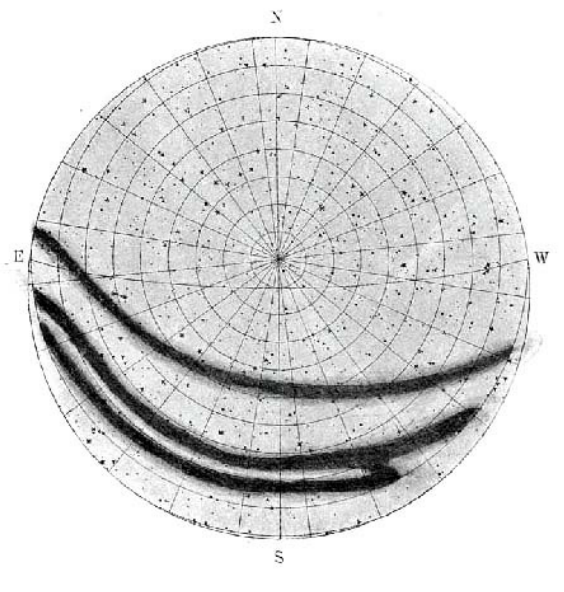
Fig. 7. All-sky drawing by Westman of the aurora as seen from Treurenberg Bay on 27 January 1900 at 16:50 UT. Somewhat earlier the same day, at 16:00 UT, Sykora described the aurora as seen from Konstantinovka: “Three Auroral bands were placed from the Savich Mountain (South-West) to the Chebyshev Mountain (East). The first is near Zenith, the second is to the South not far off Zenith and the third one is between them. Intensity: 3.”